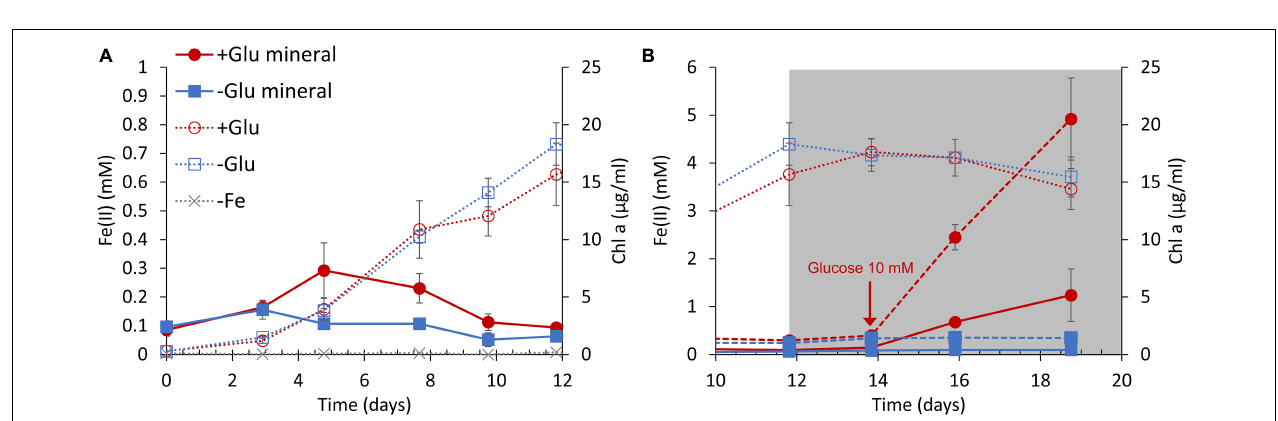
FIGURE 3 | Time courses of ferrihydrite reduction determined using a ferrozine assay. (A) A comparison of ferrihydrite reduction under anaerobic (red line) and aerobic (blue line) conditions. (B) The effect of glucose concentration on ferrihydrite reduction by S6803 cells. Red, orange, green, blue, and black lines indicate initial glucose concentrations of 15, 5, 3, 1, and 0 mM, respectively. Red lines in (A,B) are identical data. Values are means ± one standard deviation (error bars) of three replicate trials.